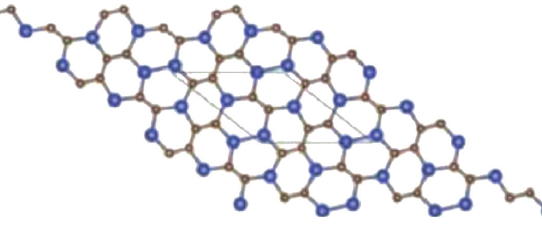
Figure 6: Sheet of Si